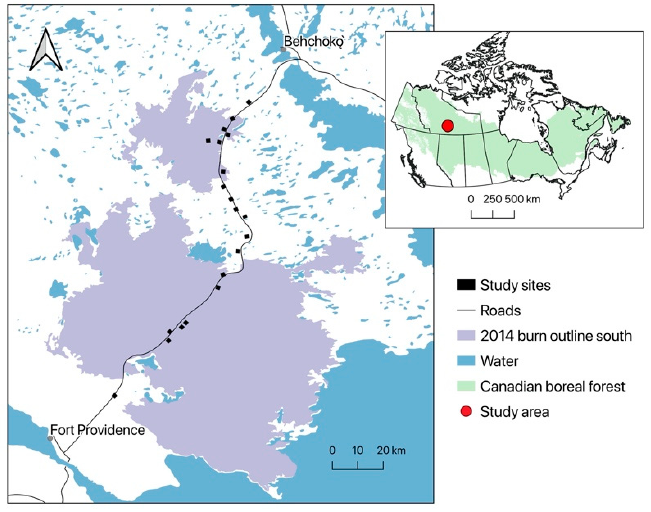
Figure 1. Location of the 20 study sites (black squares) in the study area between Fort Providence and Behchokò˛, Northwest Territories, Canada.